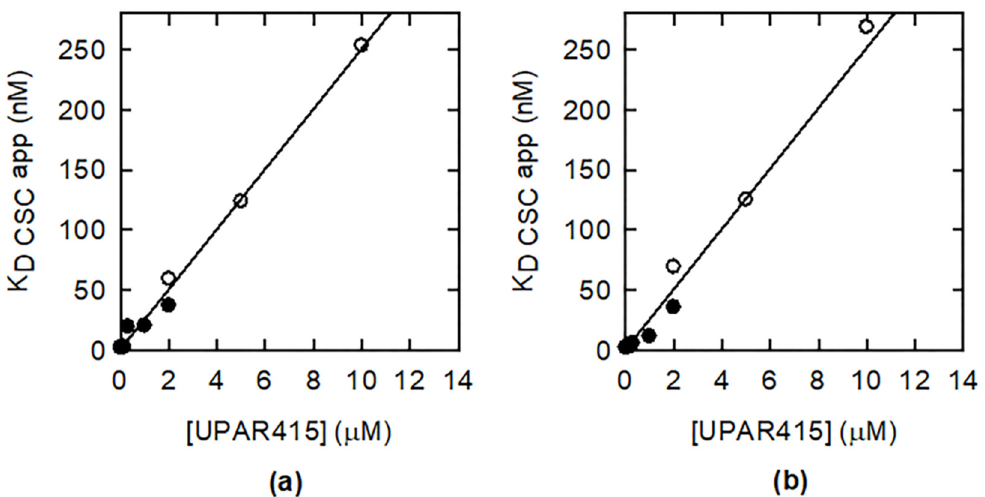
Figure 7. Apparent dissociation constants of StCS ( a ) and EcCS ( b ) complexes as a function of UPAR415 concentration, obtained by SPR single-cycle kinetics fitted to a 1:1 binding model (closed circles) and fluorescence titrations (open circles). Data were fitted to Equation (4) (see Materials and Methods, rearranged to derive the apparent dissociation constant K D,app ) giving an offset of the order of 10 − 9 M. This value, which represents extrapolated CS complex dissociation constants, is in good agreement with the independently determined values reported in Table 1 (2.3 nM for both CS complexes).